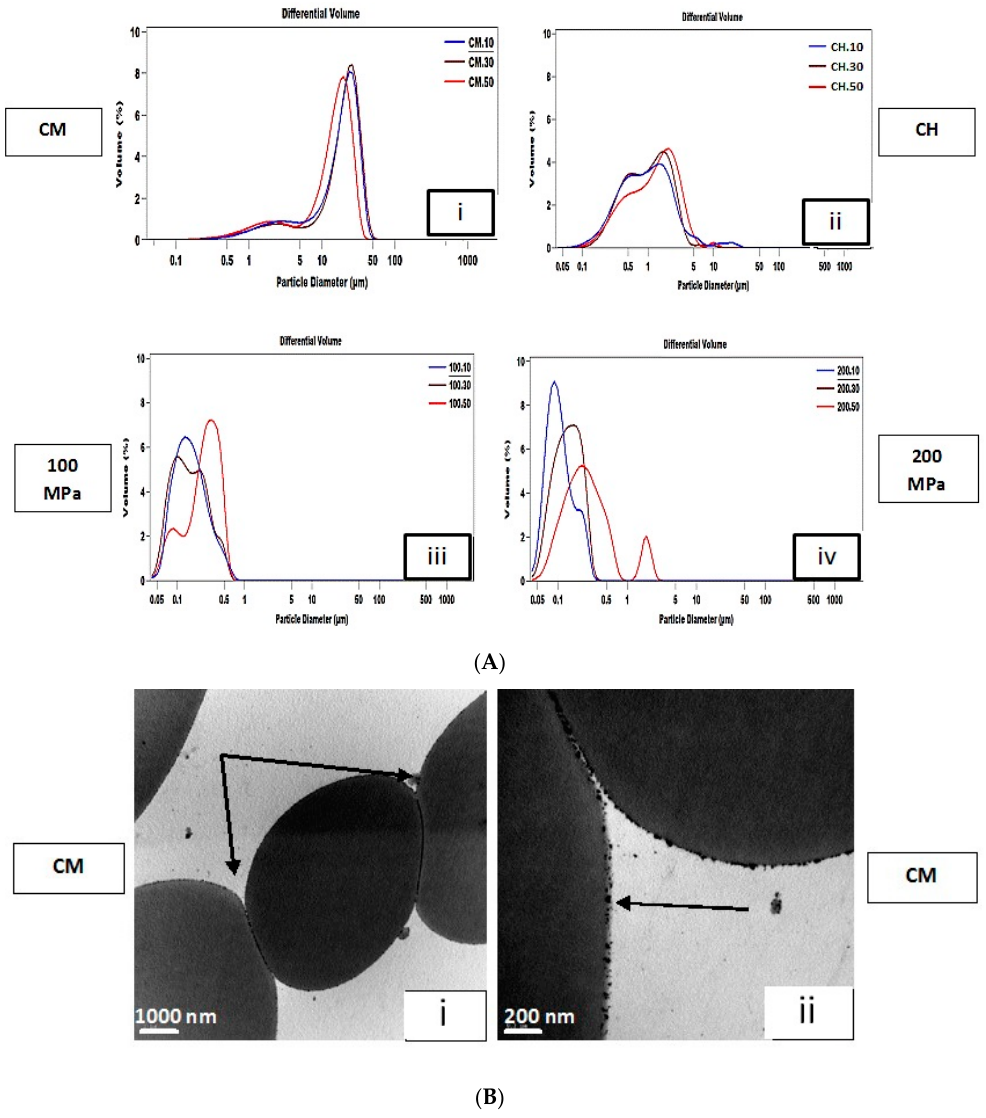
Figure 1. ( A ) Droplet size distribution curves measured by light scattering of oil-in-water (O/W) emulsions containing 10%, 30% and 50% oil plus 4% whey protein isolates (WPI) processed by ( i ) CM, ( ii ) CH and UHPH at ( iii ) 100 and ( iv ) 200 MPa; ( B ) TEM images of O/W emulsions stabilized by CM ( i , ii ) containing 30% oil ( i ) × 10,000 and ( ii ) × 50,000,